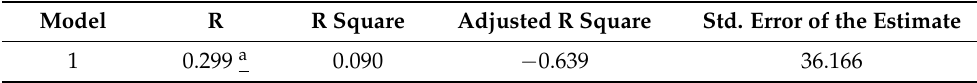
Table 6. Model Summary.